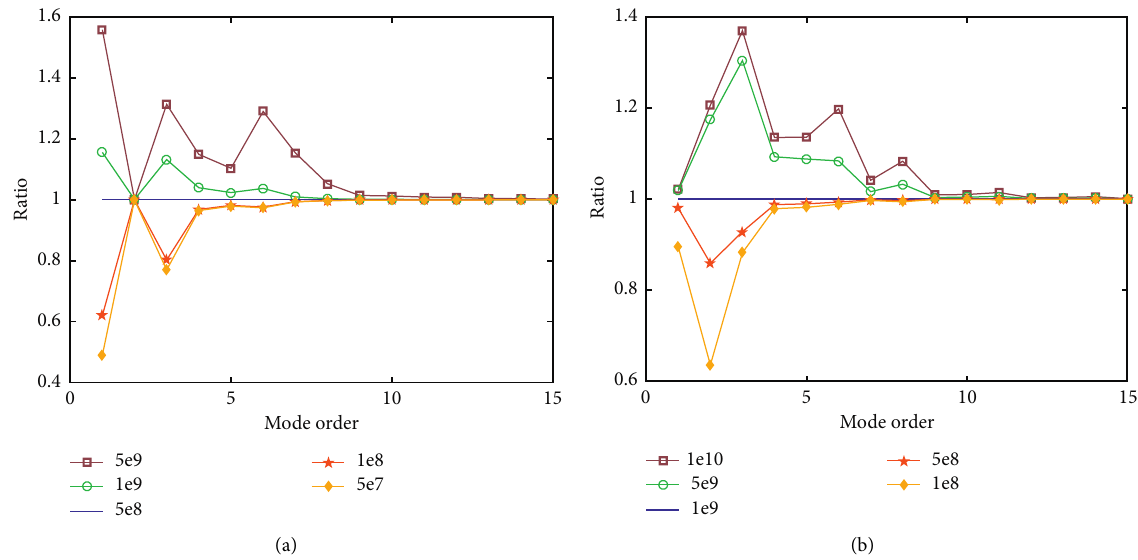
Figure 5: Influence of various bearing support stiffnesses on the modal frequencies under F-C boundary condition. (a) Stern rear bearing; (b) stern front bearing.